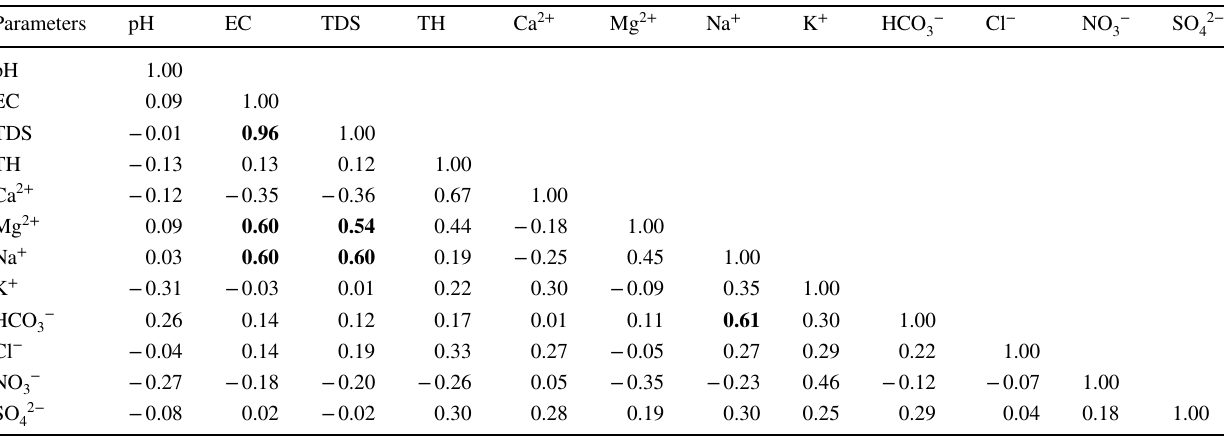
Table 7 Correlation matrix for groundwater samples (post-monsoon)